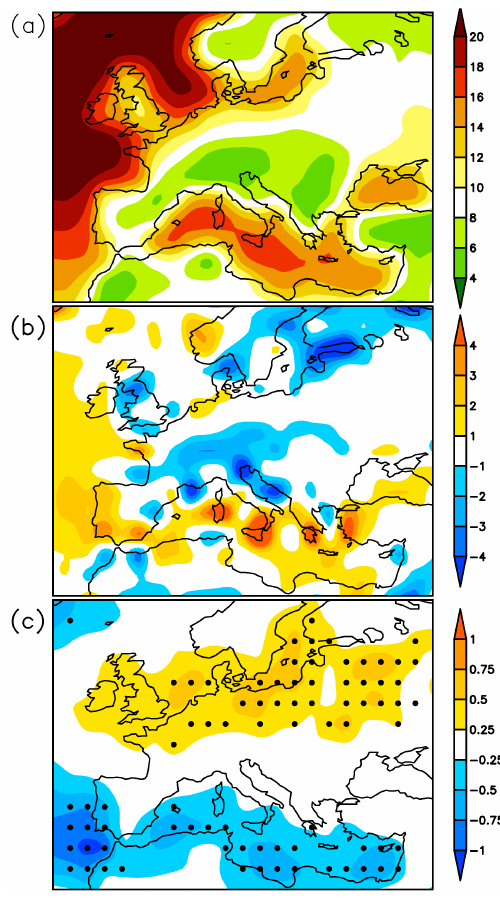
Fig. 3. Ensemble mean of 98th percentile of WIMAX in the GCM simulations. (a) Absolute values for 20C (1961–2000, unit: ms − 1 ), (b) anomaly GCM ensemble (20C) relative to ERA40 (unit: ms − 1 ), (c) changes for A1B (2071–2100) relative to 20C (1961– 2000): coloured areas indicate the magnitude of change (unit: ms − 1 ), statistical significance above 0.95 is shown by black dots (Student’s t -test)